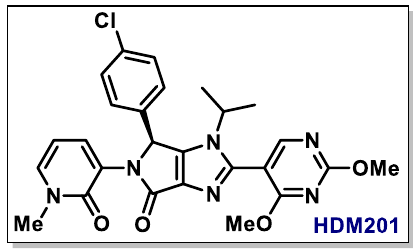
Figure 8. Structure of the p53-MDM2 inhibitor HDM201.